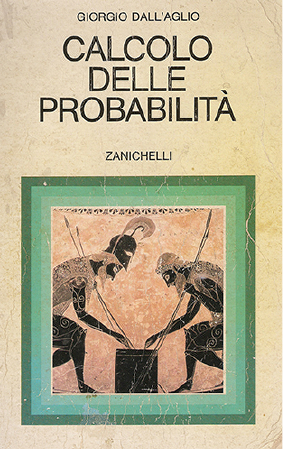
Figure 2: The cover of the book Calcolo delle Probabilità ( Probability Theory , see [15]) by Giorgio Dall’Aglio, in its first edition as published by Zanichelli, Bologna, in 1987. On the original cover one can read the names of the players, Achilles and Ajax, and the words they pronounce, “four”and